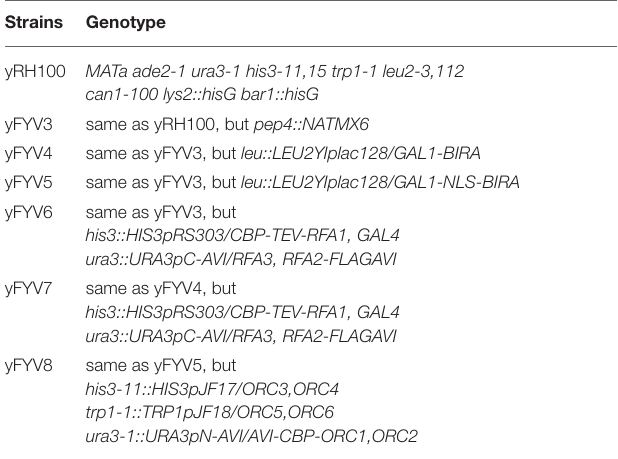
TABLE 1 | Yeast strains used in this study. Strains